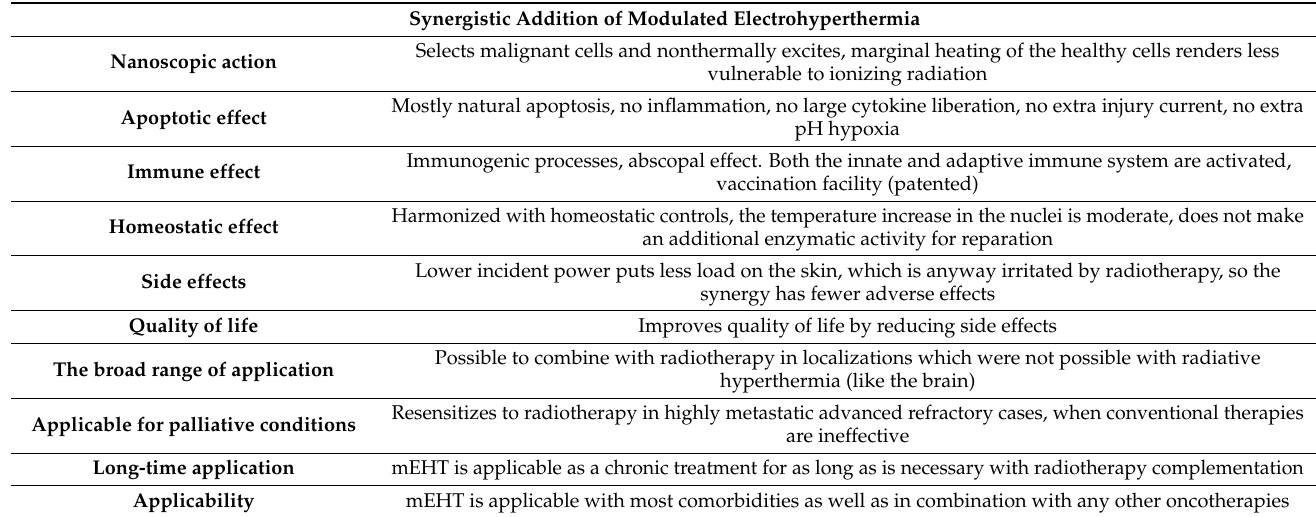
Table 3. The essential addition of mEHT to the synergistic RT-with-hyperthermia methods. Synergistic Addition of Modulated